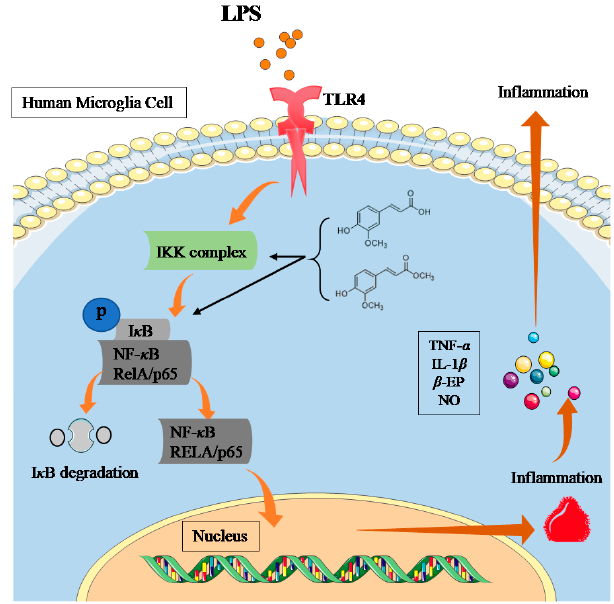
Figure 5. A schematic diagram of the potential molecular mechanism of the anti-neuroinflammatory effects of two ferulic acid derivatives, TJZ-1 and TJZ-2, isolated from Z. armatum , through the NF- κ B signaling pathway.